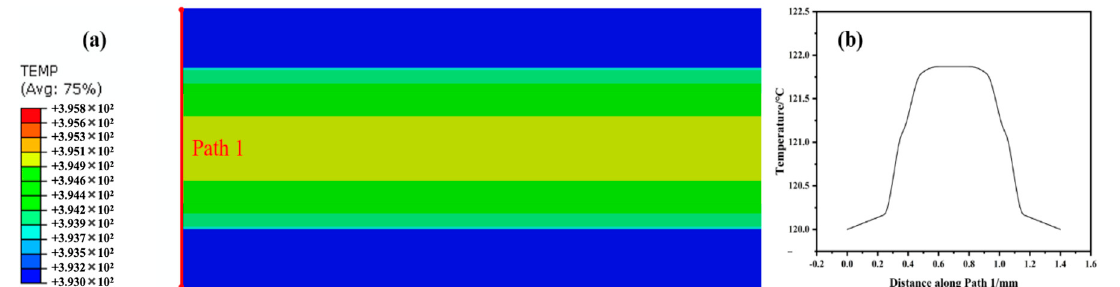
Figure 5. ( a ) The nephogram of temperature distribution along the thickness at t = 12,000 s. ( b ) The variation in temperature along Path 1.